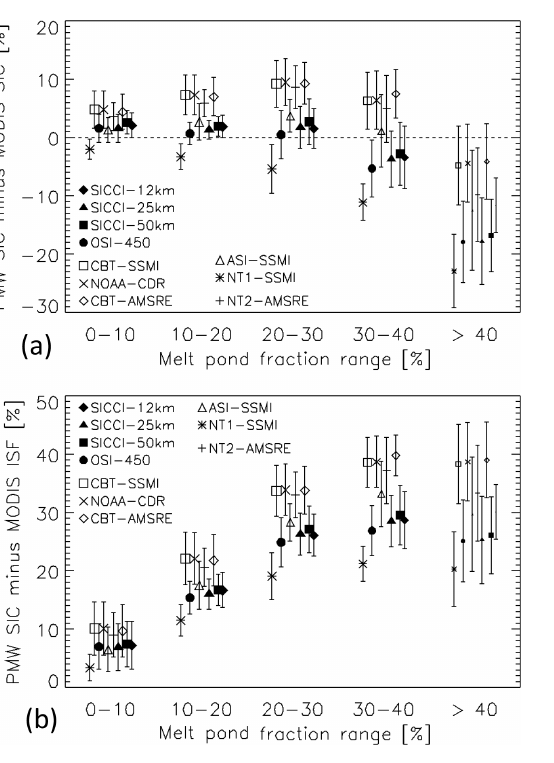
Figure 11. Mean difference of PMW SIC minus MODIS SIC (a) and PMW SIC minus MODIS ISF (b) derived for all 8d periods of the years 2003–2011 for all 10 products separately for melt pond fraction ranges 0,%–10% to > 40%. Error bars denote 1 standard deviation of the mean. Symbol size scales with the number of valid data pairs. The topmost four and bottommost three entries in the left column of annotations denote group I (filled symbols) and group II, respectively. The topmost two entries and the last entry in the right column of annotations denote group III and group IV,